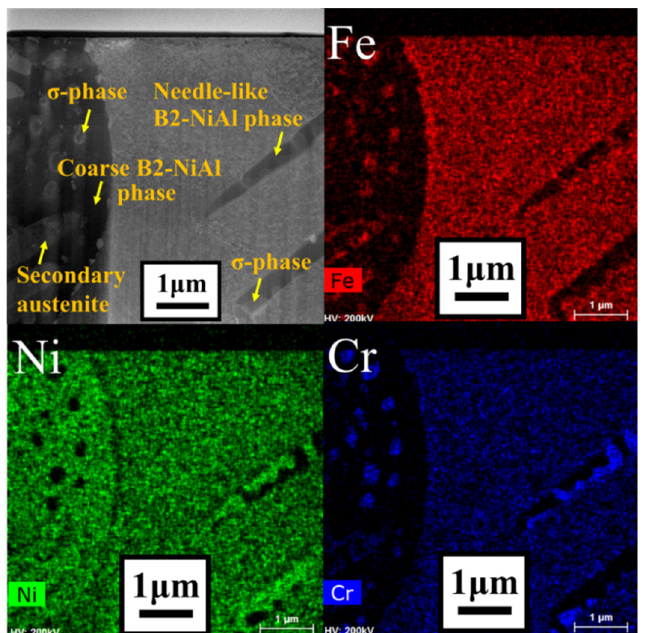
Figure 13. STEM-EDS mapping analysis for the alloy 42+ SA after the creep test in air at 750 °C and 150 MPa.